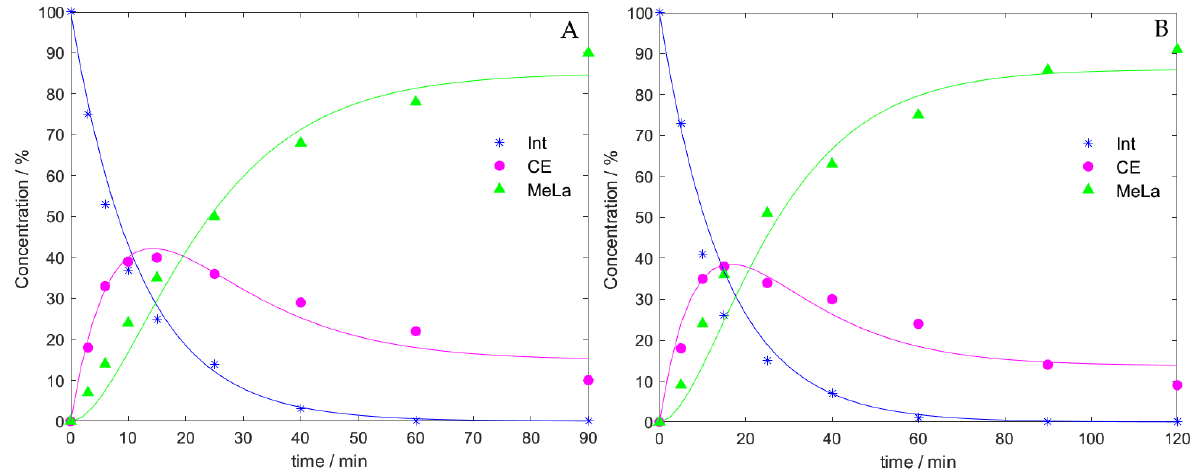
Figure 4. Reaction profiles obtained from 1 H NMR spectroscopic data for methanolysis fitted in MATLAB. ( A ) 130 °C ( B ) 120 °C.